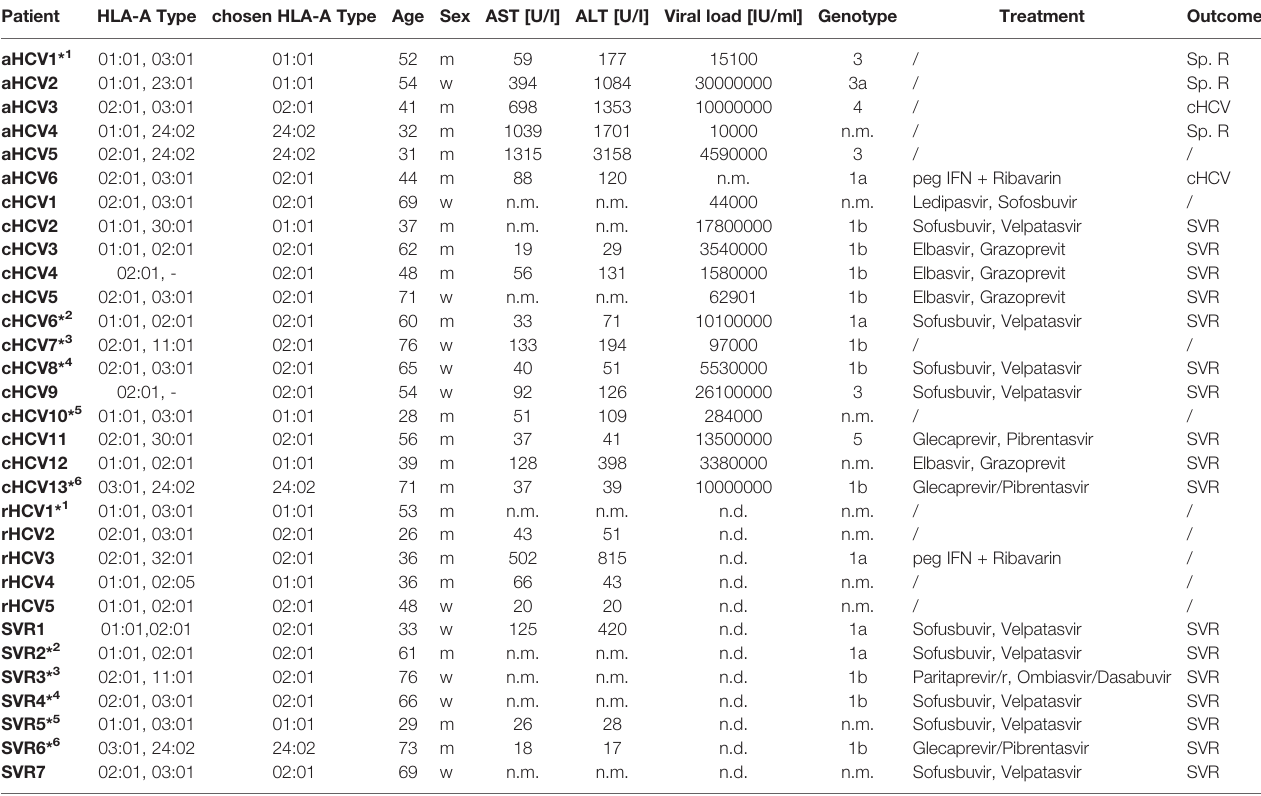
TABLE 1 | Clinical, virological, and immunological patient characteristics.